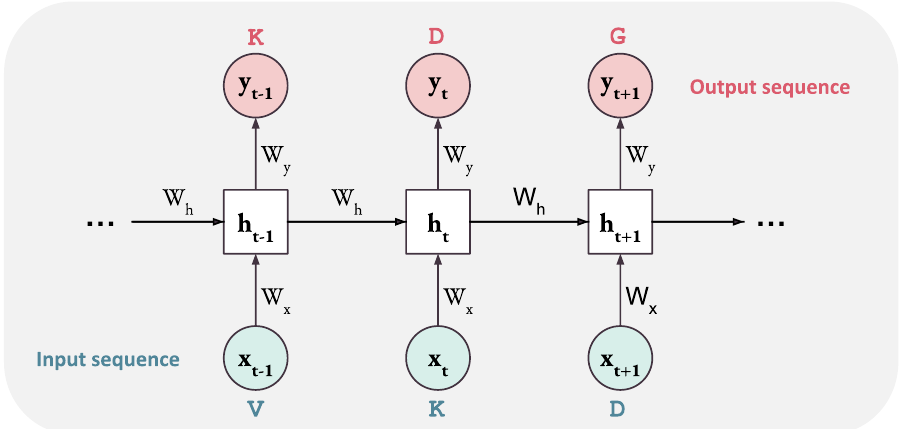
Figure 4. Pipeline of a Recurrent Neural Network. Elements x of the input sequence are processed individually by the same weights